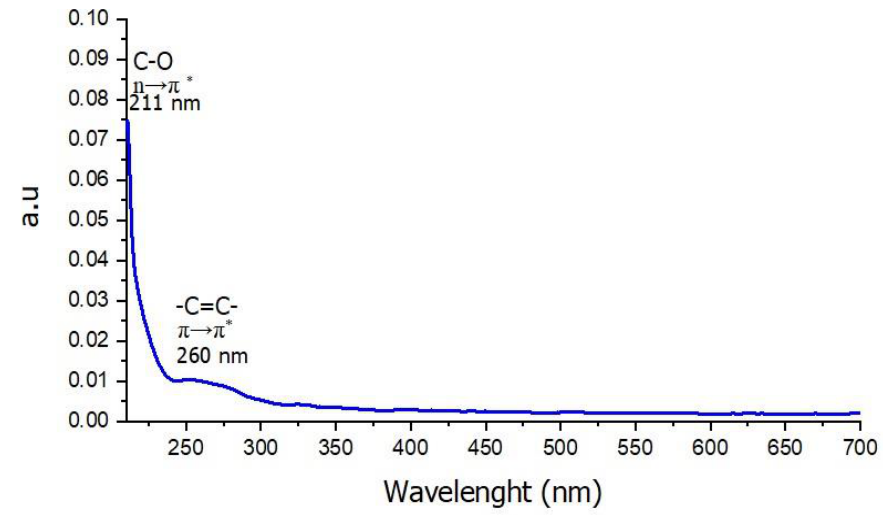
Figure 6. UV-Vis spectra of GEM. Table 2. Parameter from XRD